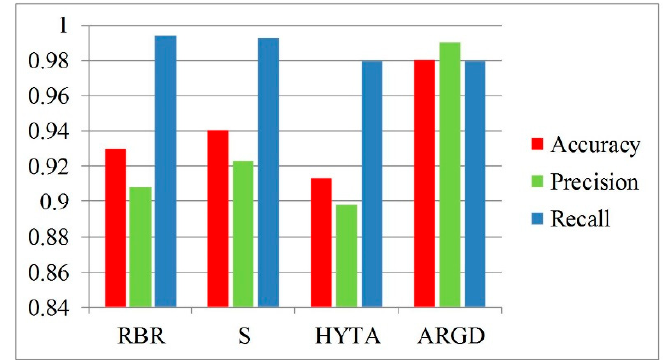
Figure 12. Evaluation results for several algorithms.